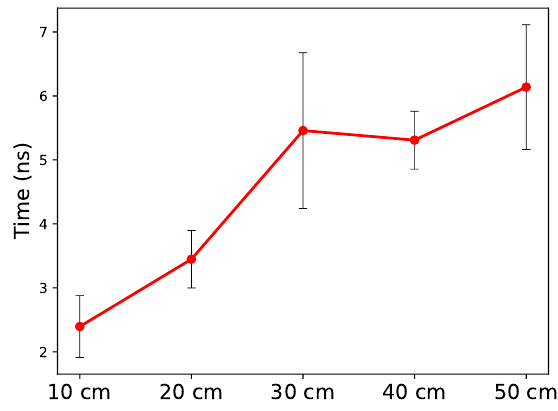
Figure 6. Propagation delay (mean and standard deviation) through the human body for eight study